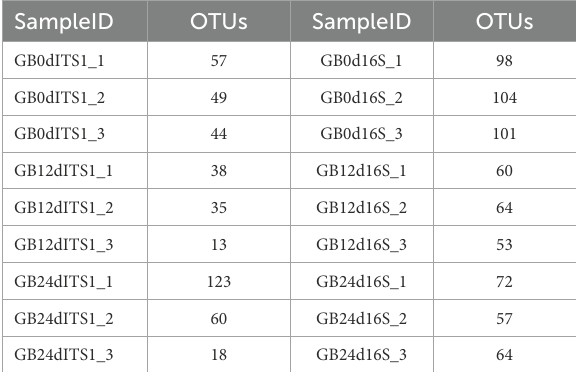
TABLE 5 Statistics of OTU numbers for individual samples.